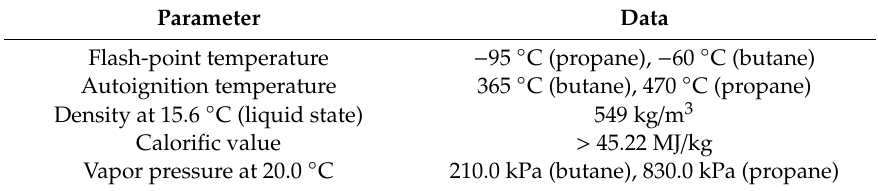
Table 4. Selected parameters of liquefied petroleum gas (LPG) used to supply the ICE.